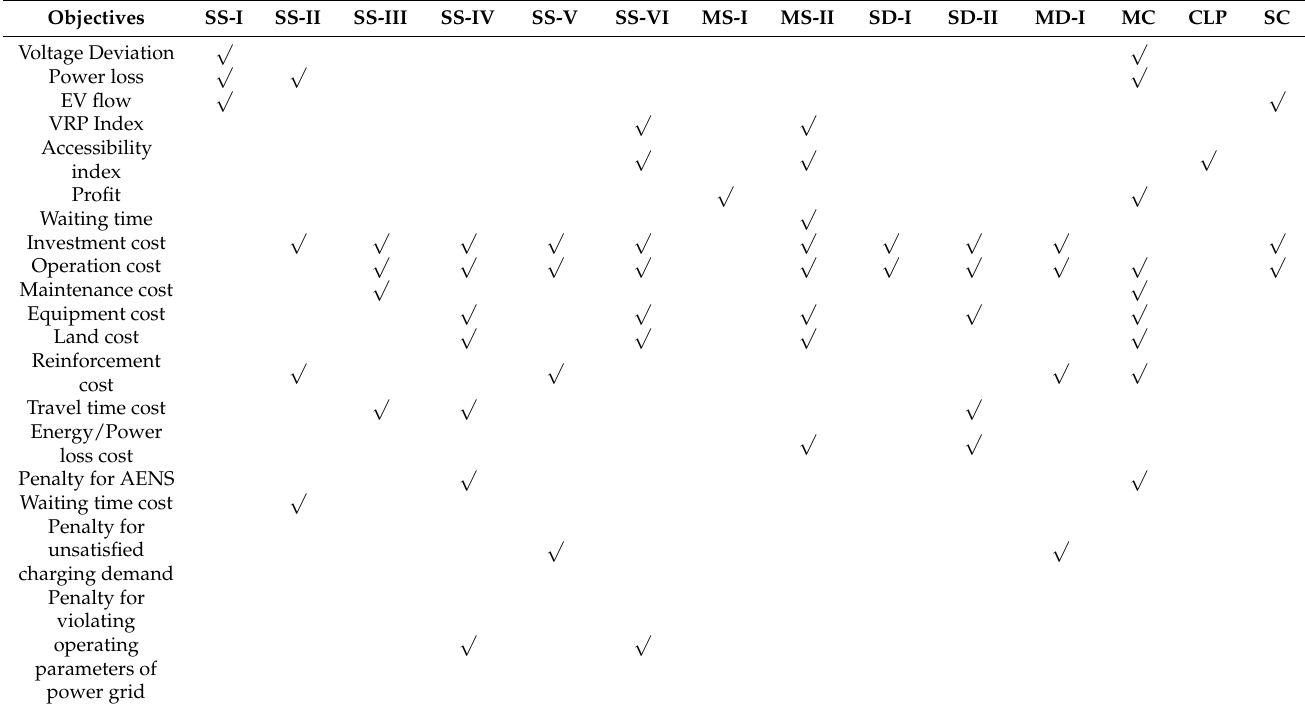
Table 7. Mapping between objective functions and planning